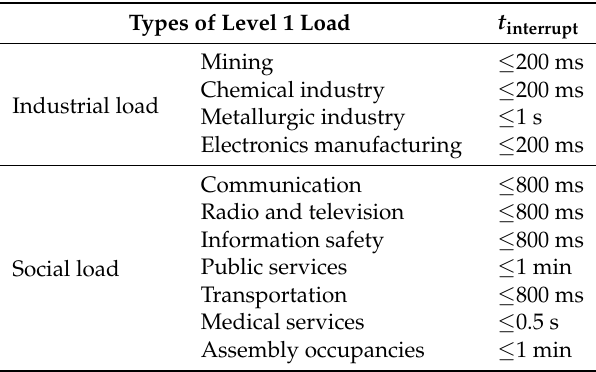
Table 4. t interrupt of major types of level 1 load.